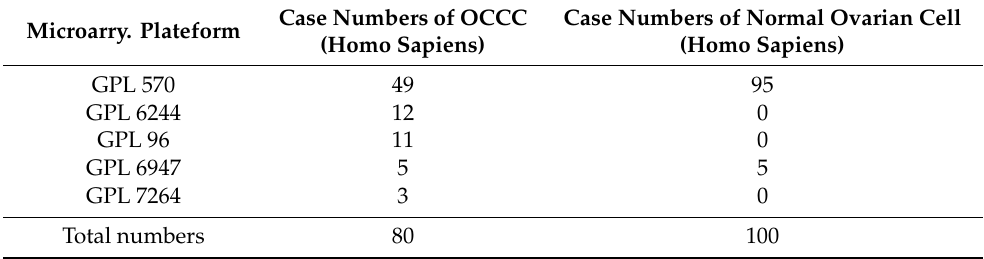
Figure 1. Workflow for selecting the six functional gene clusters. RP: ribosomal protein; EIF: eukaryotic translation initiation factor; IGF: Insulin-like growth factor. Table 1. Microarray platforms in our samples.